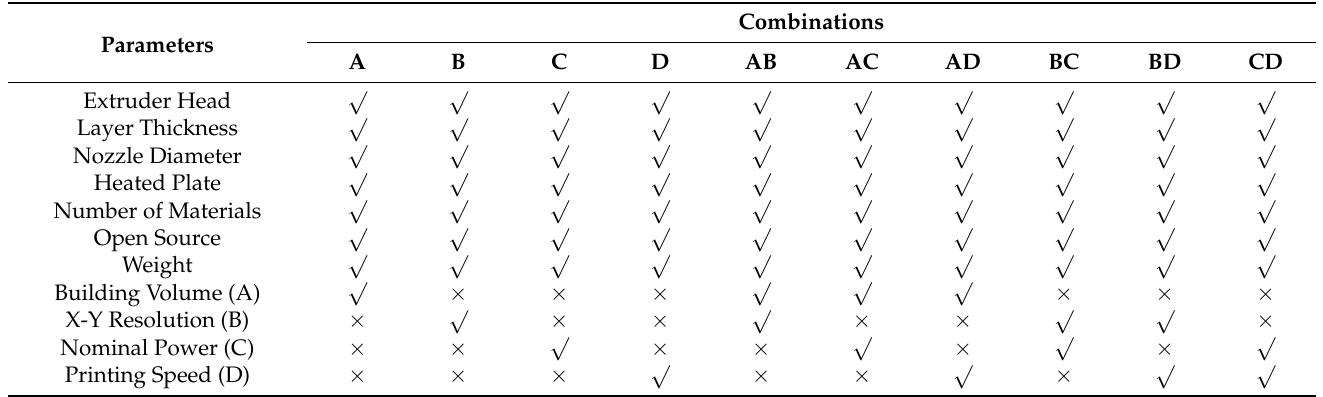
Table 5. Further examined combinations of output parameters (